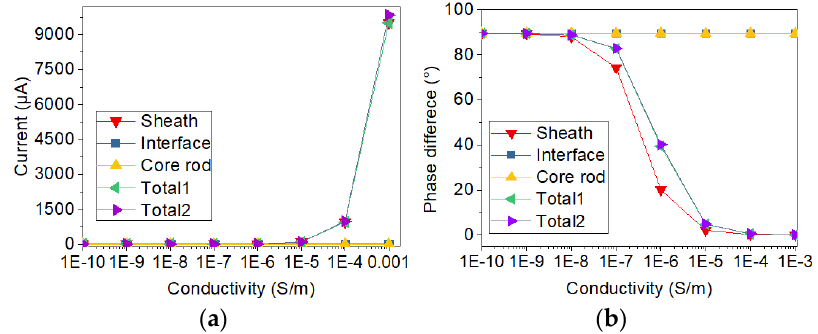
Figure 8. Current varying with conductivity of surface layer of sheath: ( a ) Change of current; ( b ) Change of phase difference.